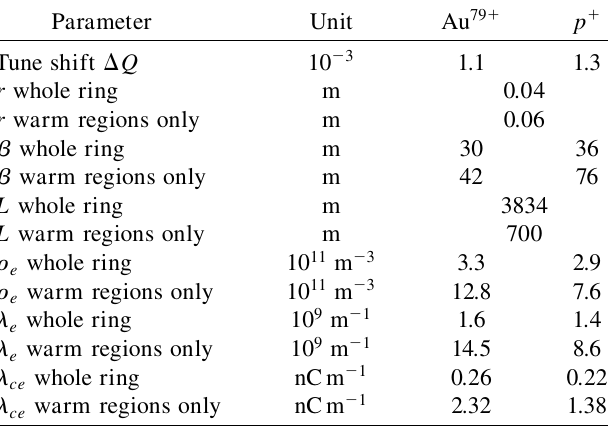
TABLE III. Machine parameters and computed electron cloud densities for different cloud lengths and